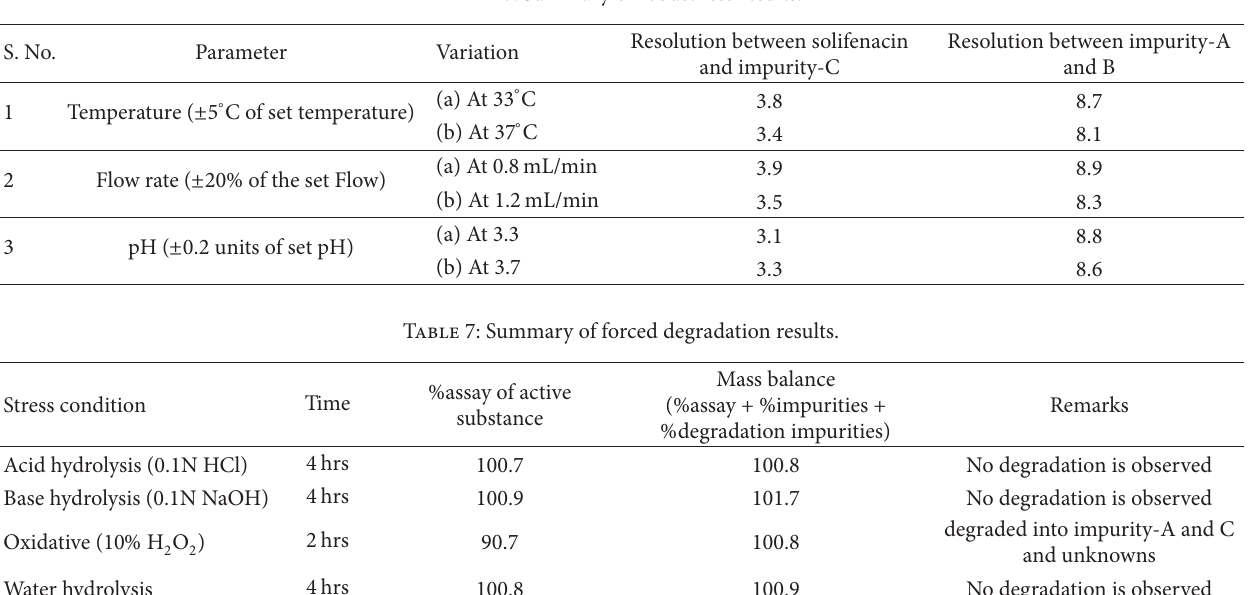
T 6: Summary of robustness results.